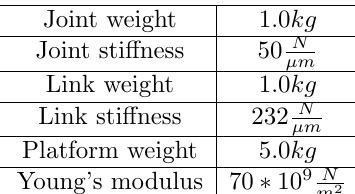
Table 2: The Gantry-Tau physical parameters.